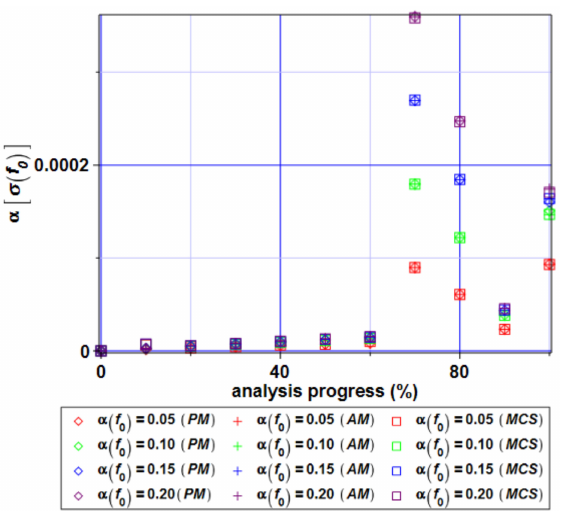
Figure 24. Coefficient of variation of the extreme von Mises stress α [ σ (f 0 )] for the